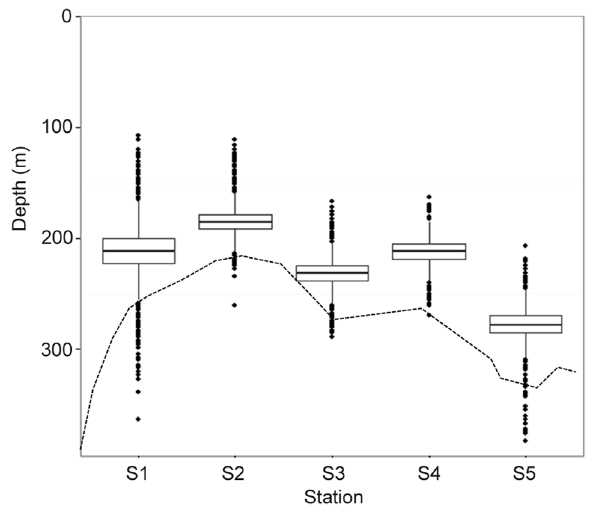
Figure 5. Passive telemetry: fish vertical habitat envelope vs. the seamount bottom profile. Boxplot of the depths (average 6 SD and outliers) recorded at each of the five main stations overlaid on the corresponding transverse section of the Condor seamount (dashed line).